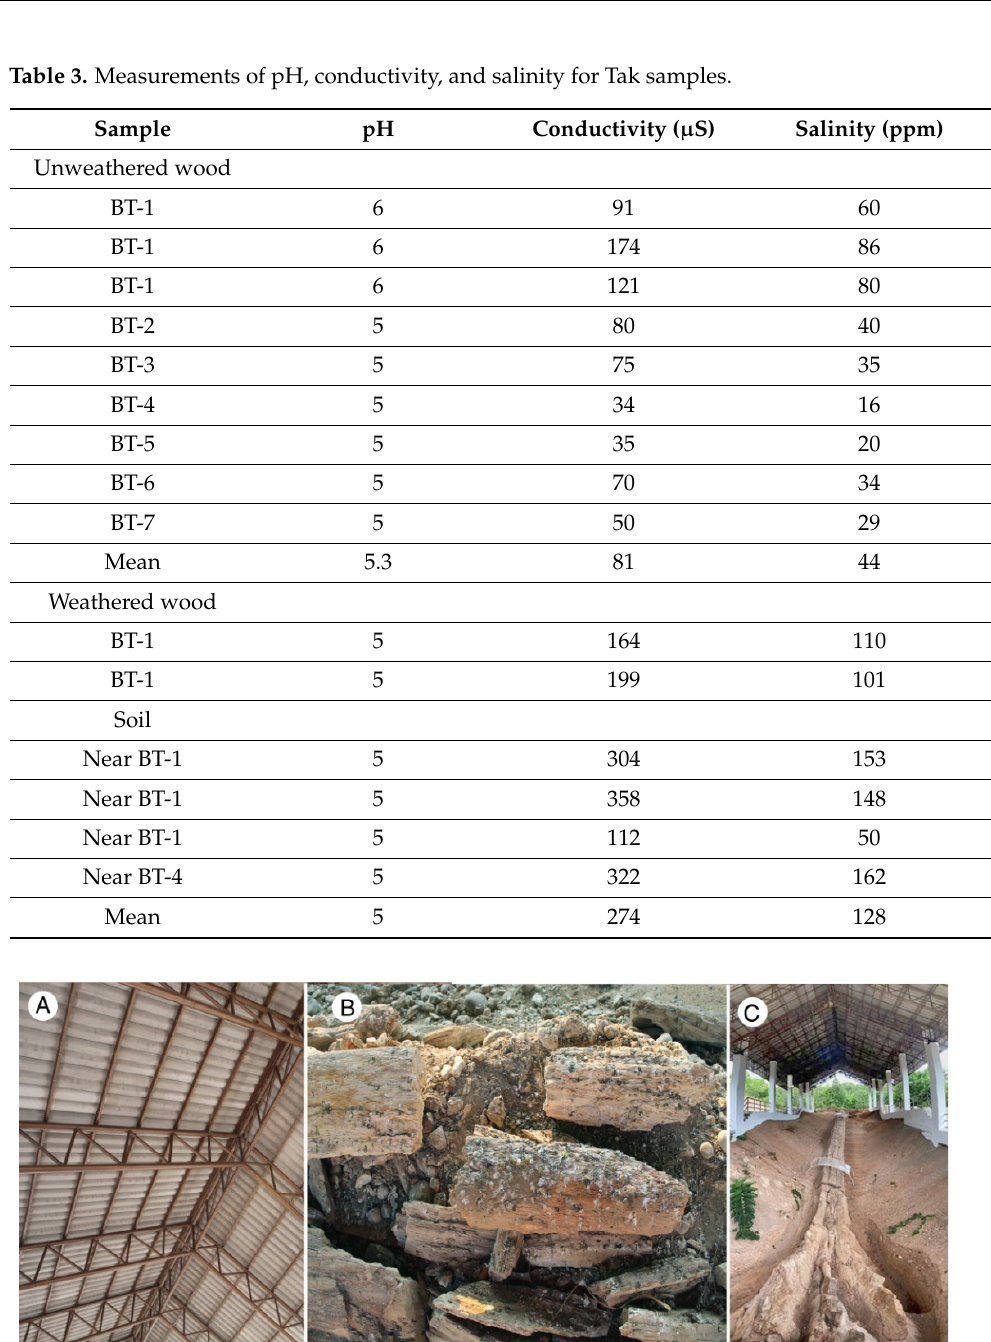
Figure 24. Permanent shelter roofs attracted nesting birds, whose droppings contaminated fossil logs. ( A ) Original roof of shelter BT-6. ( B ) Fossil wood showing abundance of fecal material. ( C ) Ceiling screen installed to prevent bird entry. A small temporary canopy positioned above the middle of the trunk provided local protection against bird excrement. Photo by Tanaklit